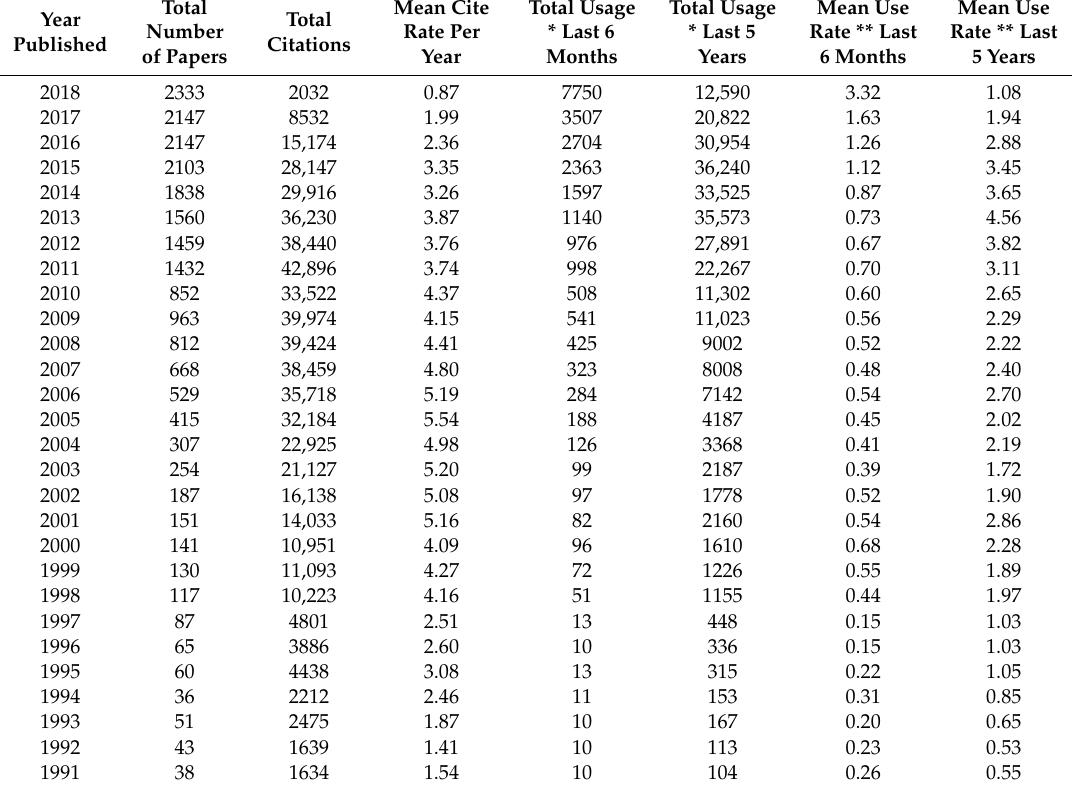
Table 2. General characteristics of